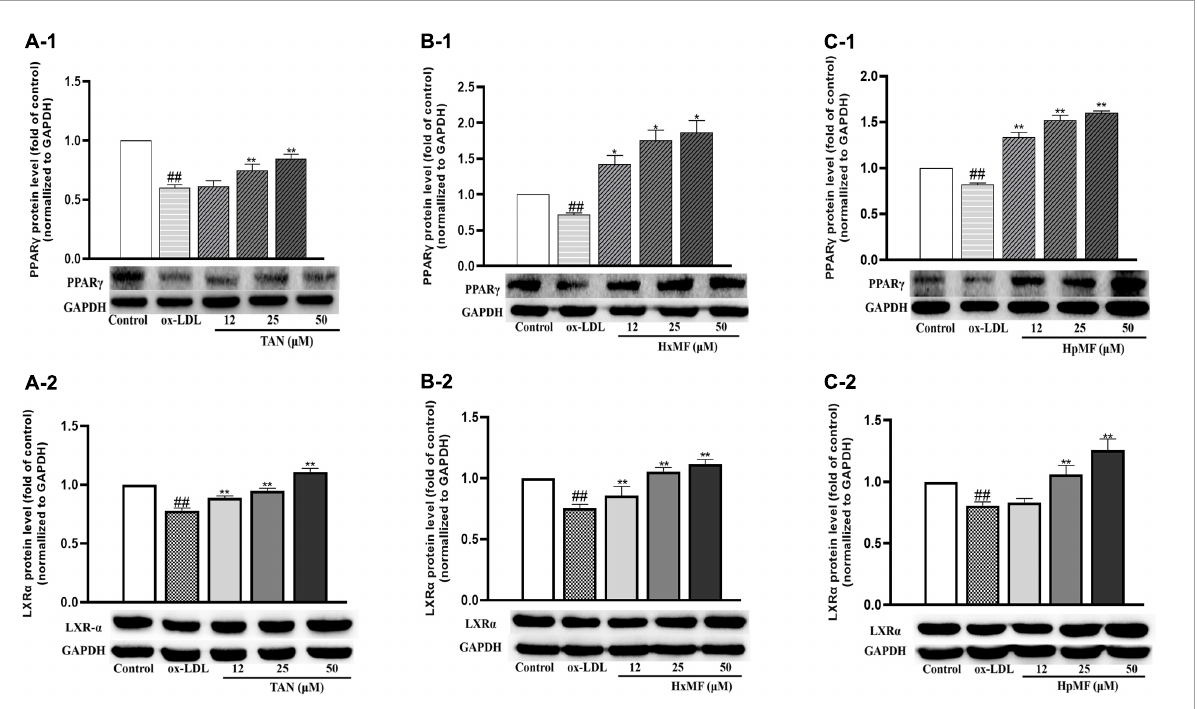
FIGURE7 Effects of TAN on protein expression of PPAR γ and LXR α in ox-LDL-treated RAW264.7 cells (A1,A2) ; effects of HxMF on protein expression of PPAR γ and LXR α in ox-LDL-treated RAW264.7 cells (B1,B2) ; effects of HpMF on protein expression of PPAR γ and LXR α in ox-LDL-treated RAW264.7 cells (C1,C2) . All experiments were run in triplicate and data showed mean ± SD. ## p < 0.01 compared with the control group, * p < 0.05 and ** p < 0.01 compared with the ox-LDL